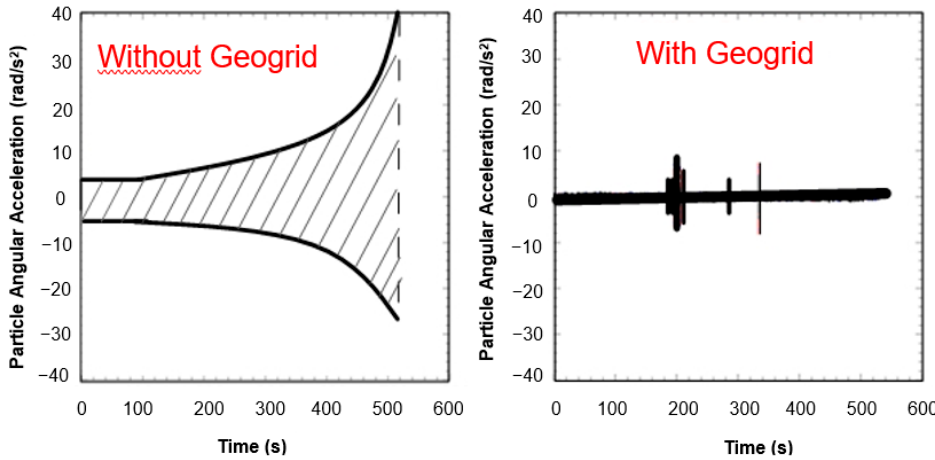
Figure 26. Reduction in particle angular acceleration over time (adapted from [145]).